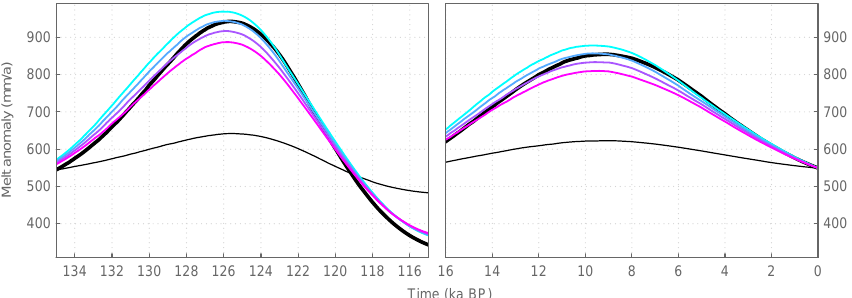
Figure 5. Greenland ice sheet melt anomalies for the Eemian (left) and the Holocene (right), given a 3 ◦ C summer temperature anomaly relative to today, calculated with the full model ( M(S) , thick black line), the reduced model ( M(S 0 ) thin black line) and an ensemble of insolation-corrected model versions ( M(S 0 ) corr ) with the parameter T min set to − 15, − 14, − 13 and − 12 ◦ C (values represented by cyan to magenta lines in the order given).